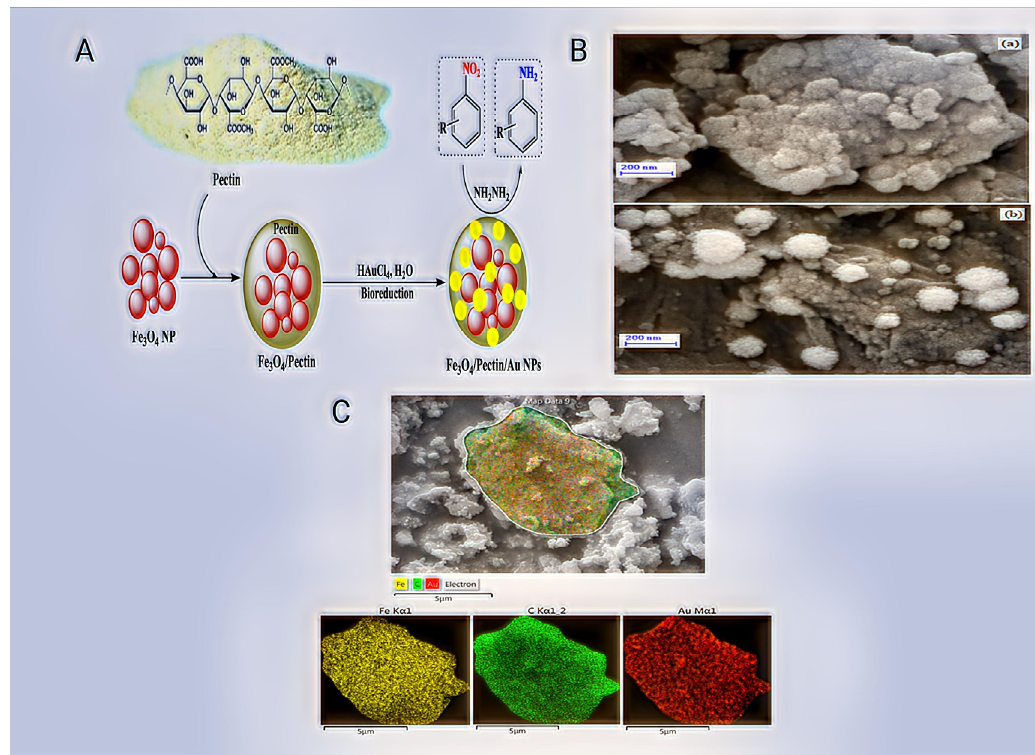
Figure 4. A novel magnetic nanocomposite (Fe 3 O 4 /Pectin/Au) for catalytic reduction of nitroarenes and investigation into its anti-human lung cancer properties, with a systematic representation of the in situ decorated Au nanoparticles on pectin-modified Fe 3 O 4 nanoparticles. ( A ) Fe 3 O 4 /Pectin/Au nanocomposite preparation and use in the reduction of nitroarenes ( B ) Homogenous dispersion of Fe, C, and Au atoms over the nanocomposite surface is shown by FESEM analysis. ( a ) Fe 3 O 4 /Pectin